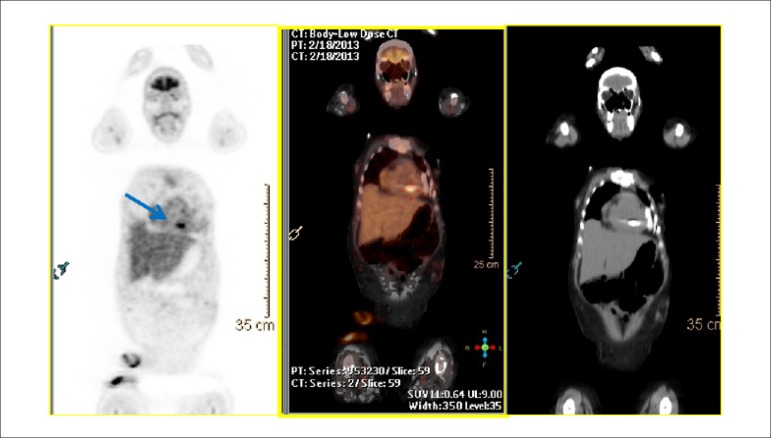
Male patient, age 65, with pacemaker implant 4 months prior (removed due to subcutaneous pocket infection); new implantation with the distal end of the right chambers. He evolved with dyspnea and fever 20 days prior; blood culture was positive for S. aureus. FDG-18F - PET/CT study was positive for endocarditis in the implant site; maximum standard uptake value (SUV) = 8.1.